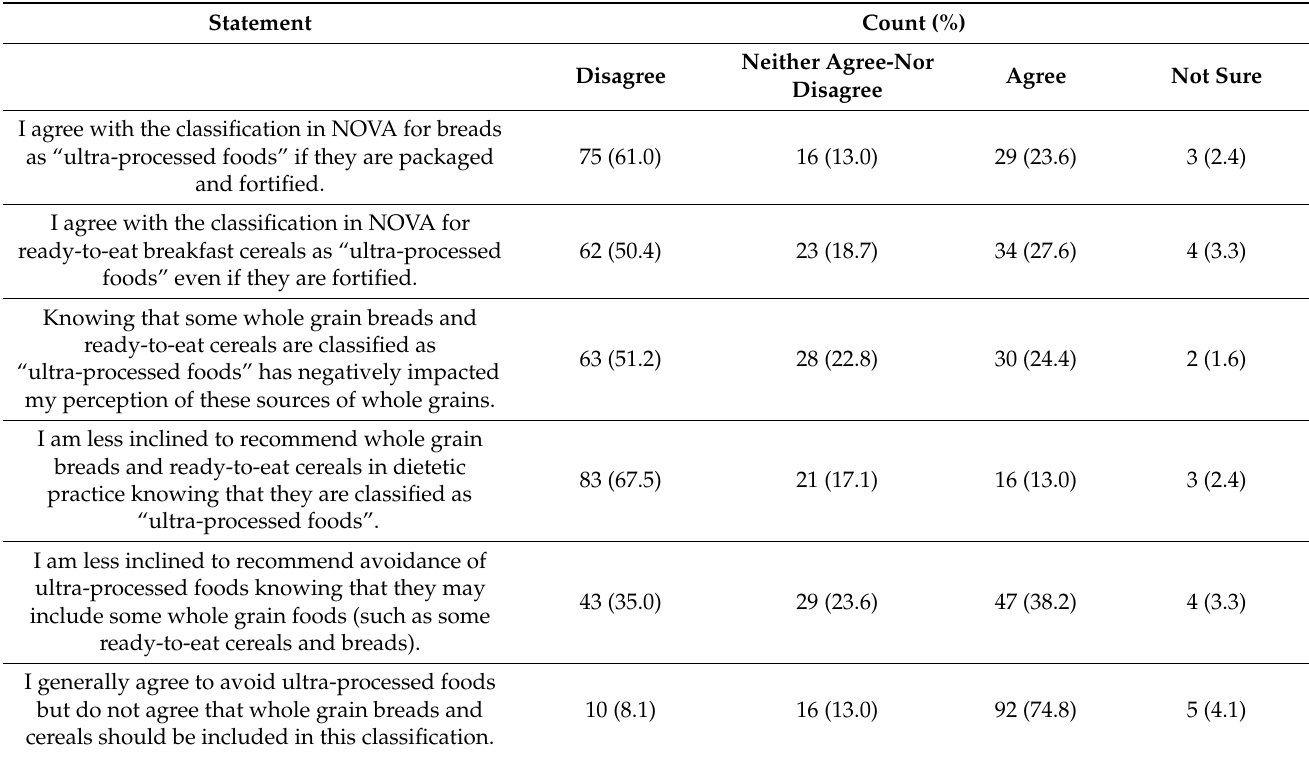
Table 5. Dietitians’ attitudes to and perceptions of whole grains, NOVA, and